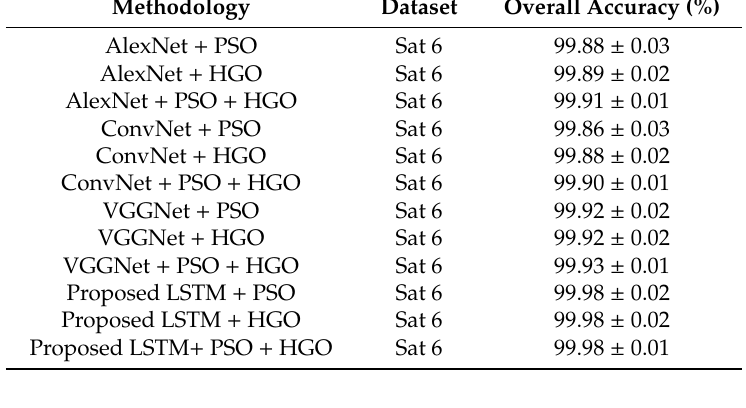
Table 13. Comparative analysis of proposed LSTM with existing neural networks on Sat 6 dataset. Methodology